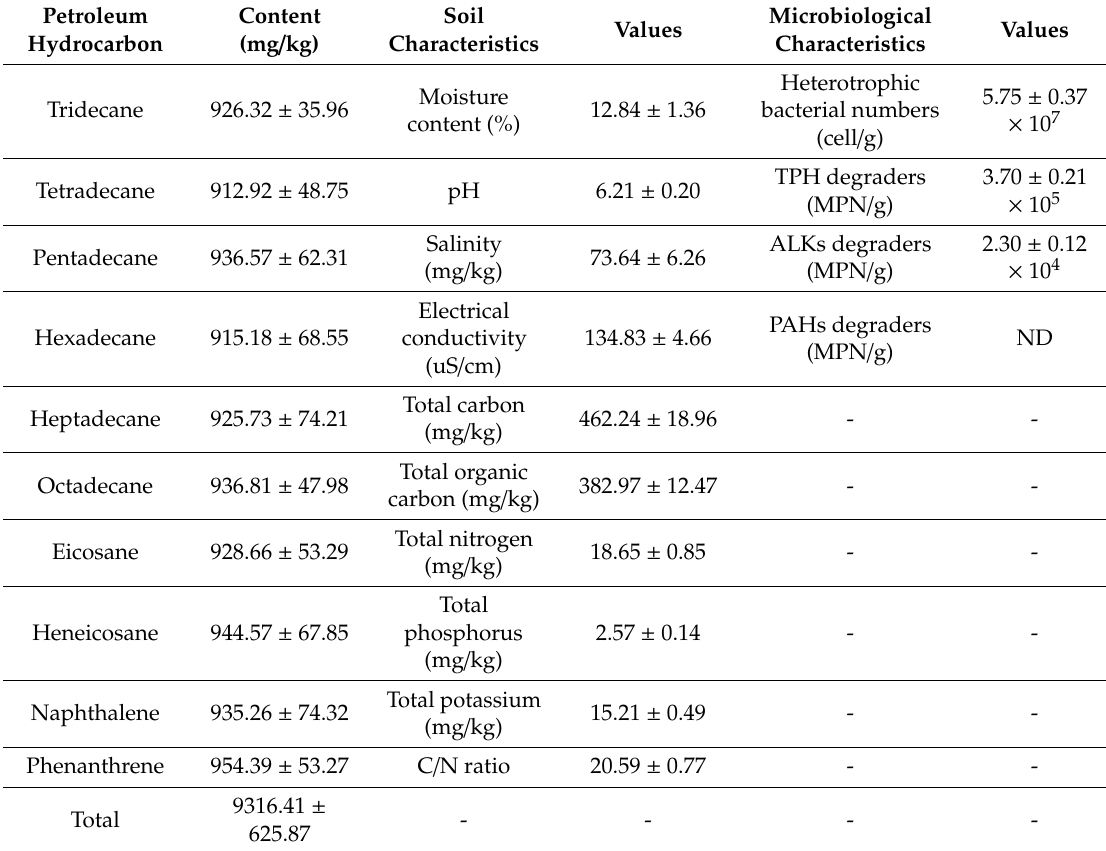
Table 1. Microbiological and physicochemical characteristics of PH-contaminated